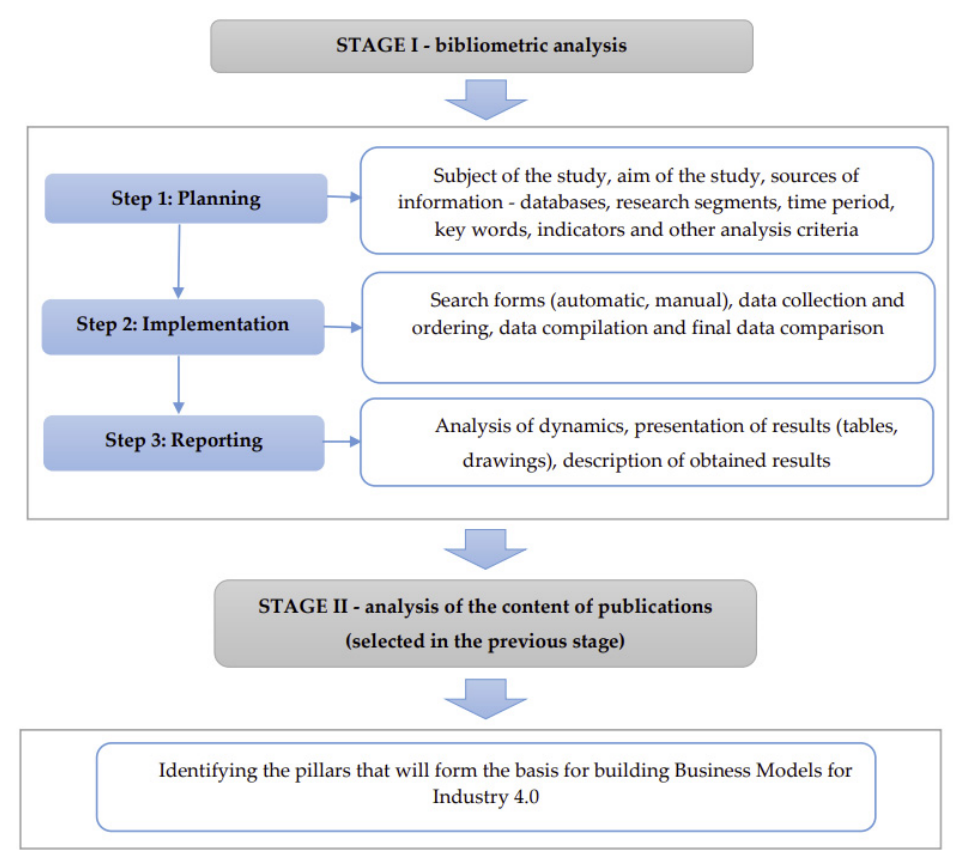
Figure 1. Research methodology. Source: own elaboration.